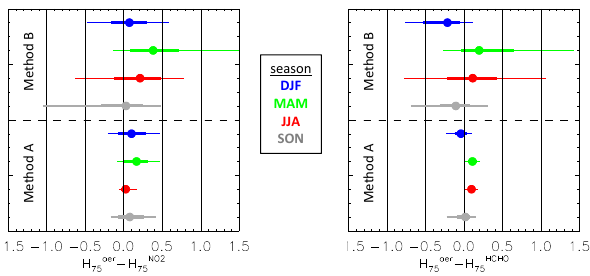
Figure 18. Box plots of difference between aerosol and trace gas profile heights (NO 2 left, HCHO right), specified per season and retrieval